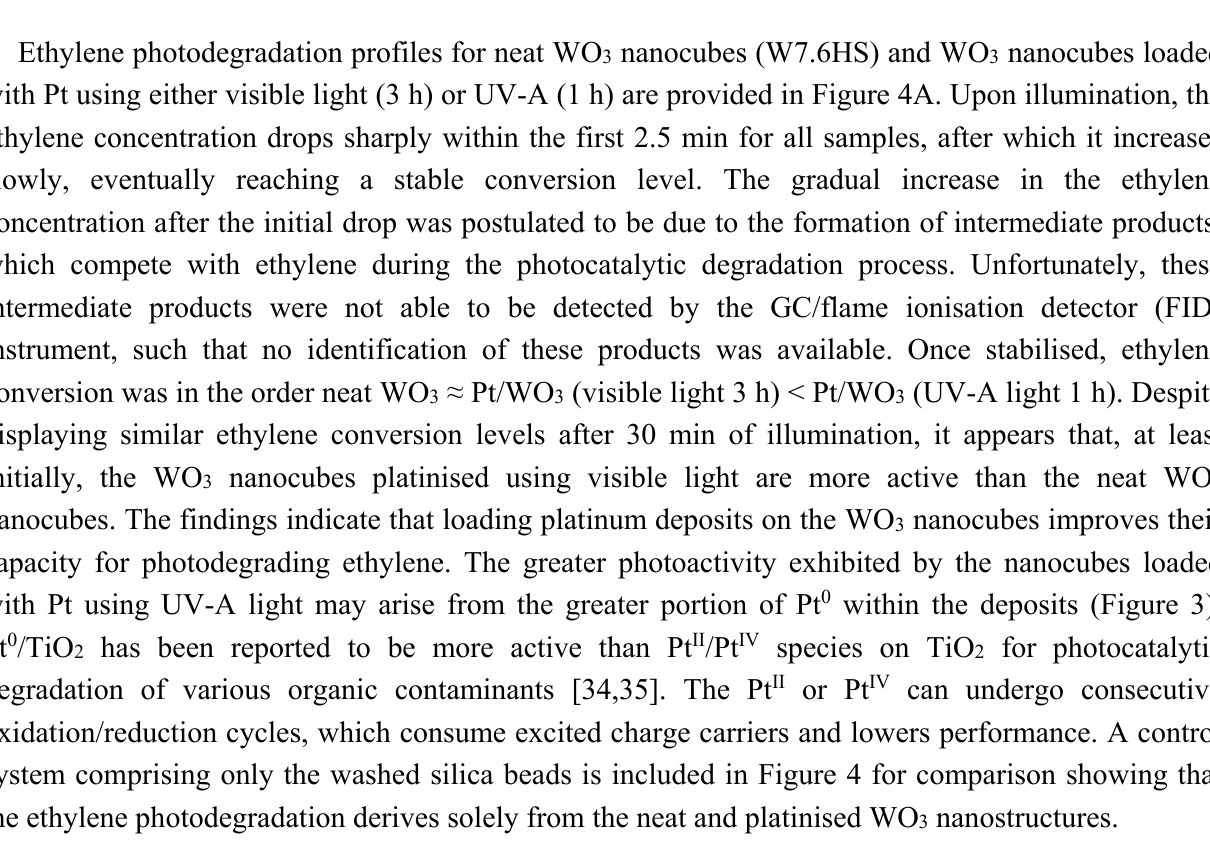
Figure 4. Photodegradation profiles displaying: ( A ) ethylene conversion with time for neat WO 3 nanocubes (W7.6HS) and WO 3 nanocubes platinised using visible light for 3 h or UV-A light for 1 h. Included is a silica control profile. ( B ) Steady-state ethylene conversion (as a percentage of initial ethylene concentration) for neat and platinised (visible light for 3 h or UV-A light for 1 h) WO 3 nanobundles (W7.6NaS), nanoparticles (WSA) and nanocubes